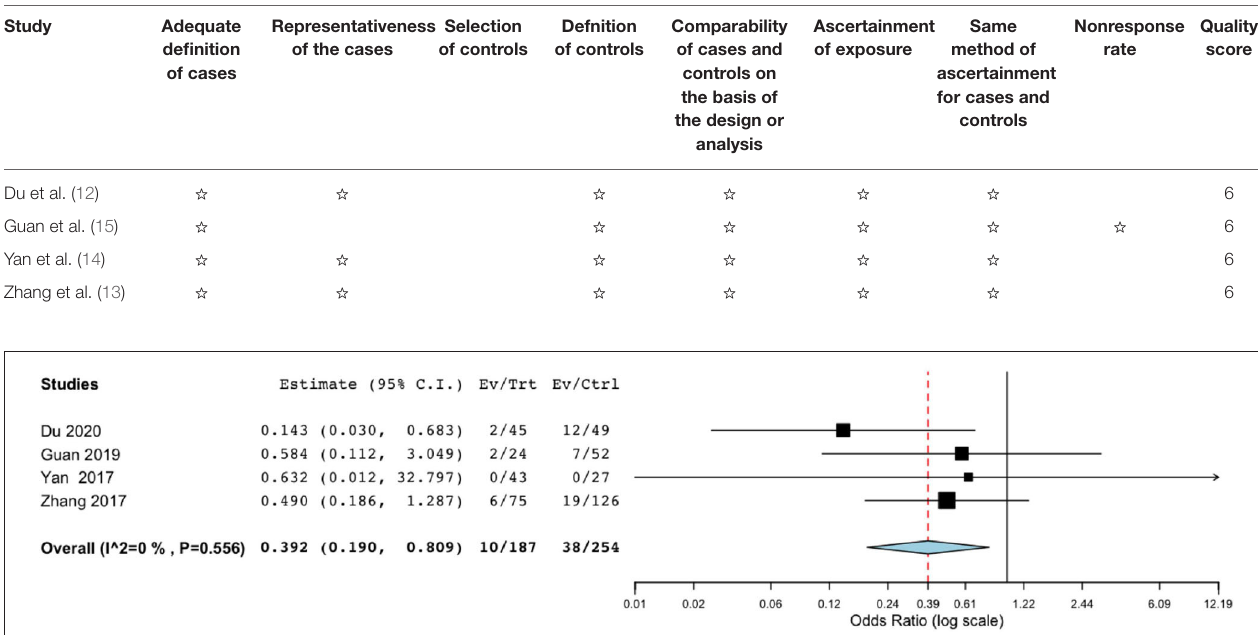
TABLE 2 | Newcastle-Ottawa Scale for assessing the quality of studies in meta-analysis.